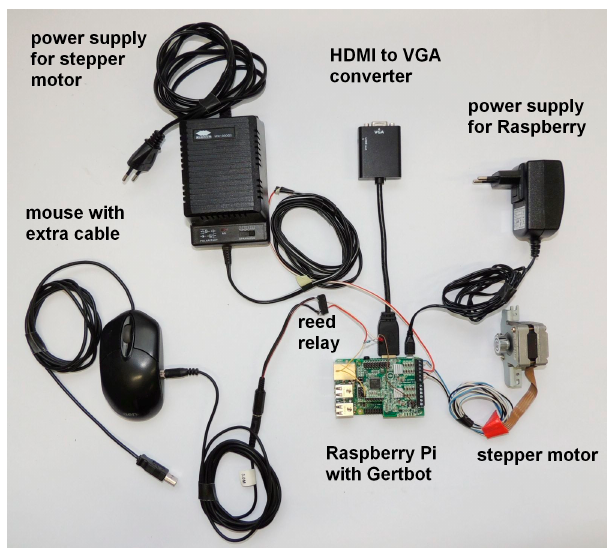
Figure 10. Raspberry Pi computer with mounted Gertbot board, the modified computer mouse and a connected stepper motor.